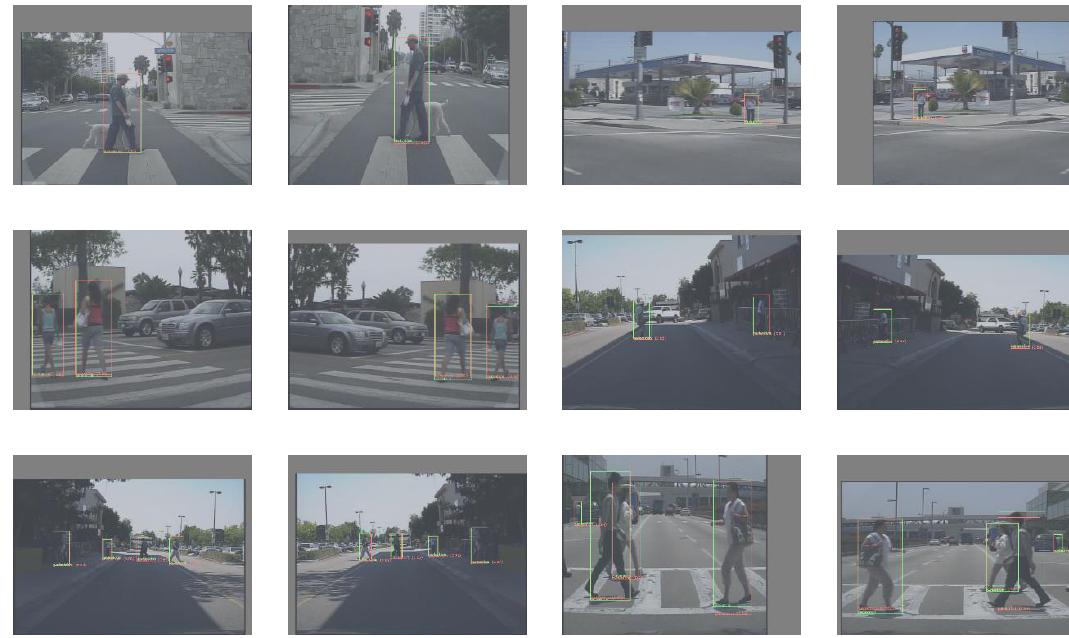
Figure 9. Take the results on Caltech–Zhang as an example, two adjacent pictures are the detection output of the same input after data augmentation.